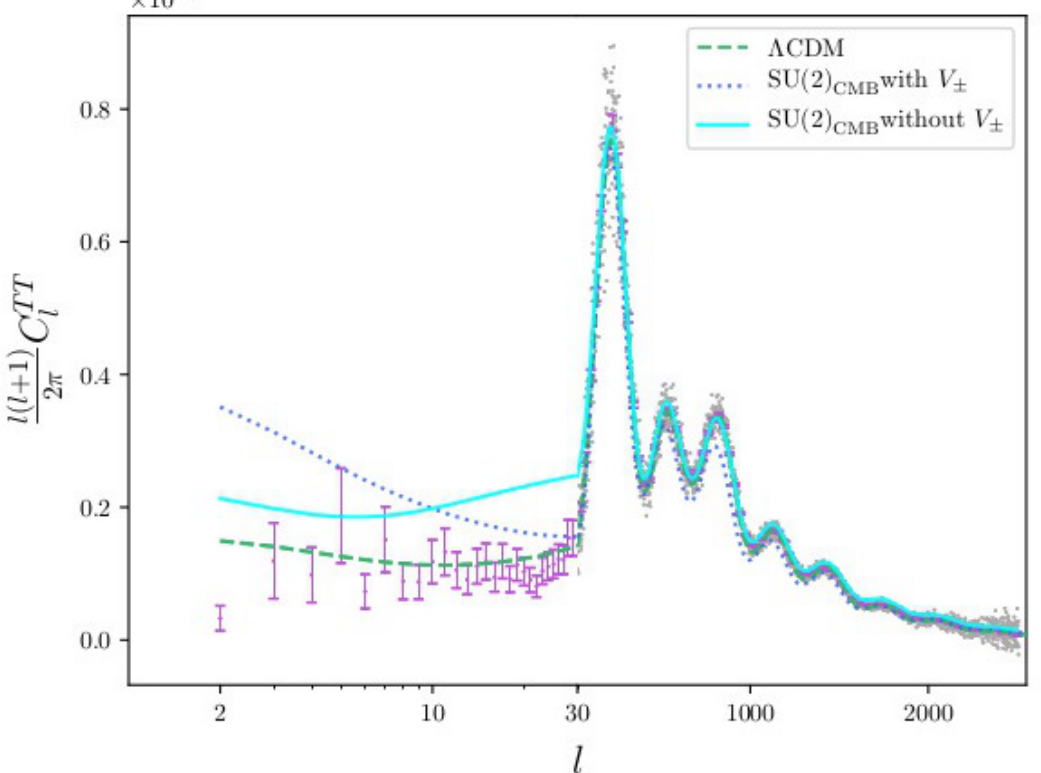
Figure 2. The TT power spectra (blue error bars and grey dots are 2015 Planck data, dashed line is best-fit Lambda-Cold-Dark-Matter ( Λ CDM) model, dotted line SU(2) CMB , also taking V ± into account in perturbation equations (SU(2) CMB + V ± ), and solid line SU(2) CMB , only taking massless mode into account in perturbation equations (SU(2) CMB